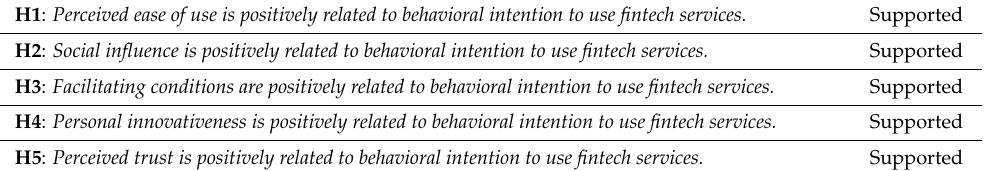
Table 8. Summary of